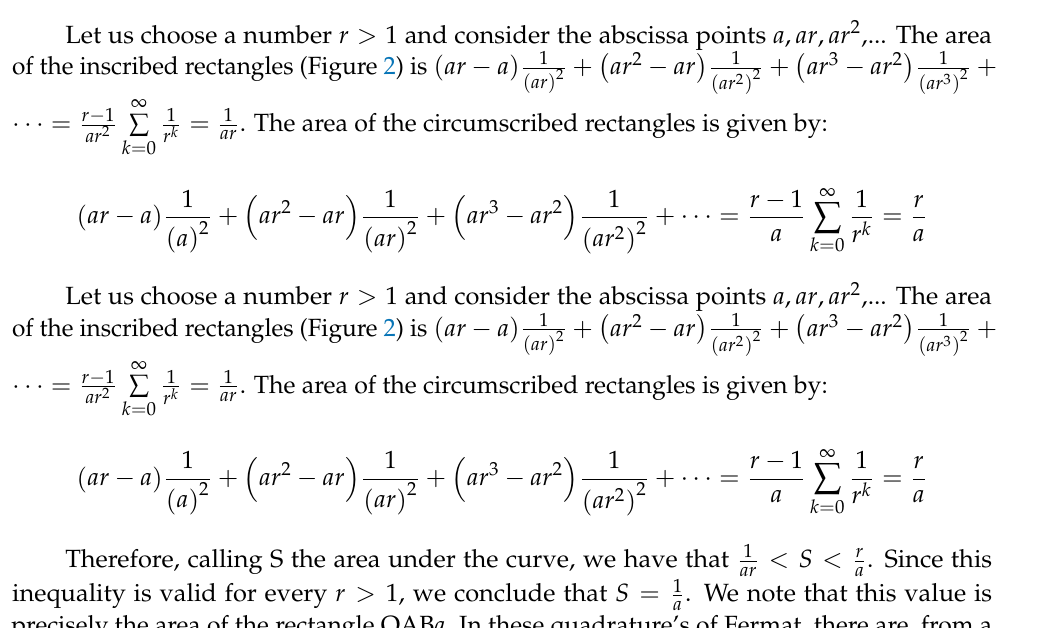
Figure 2. Quadrature of Fermat’s